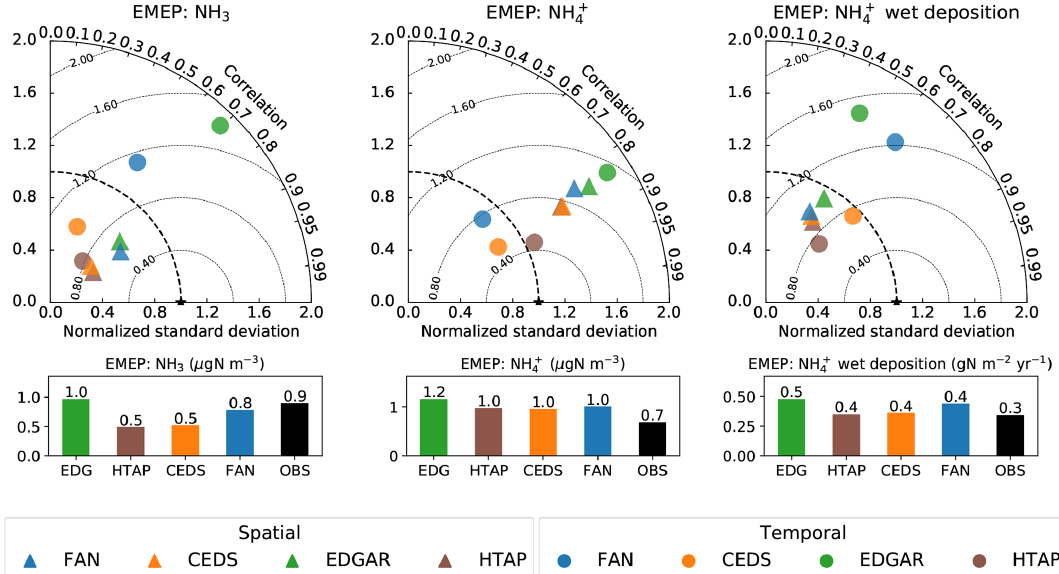
Figure 6. Same as Fig. 5 but for the EMEP